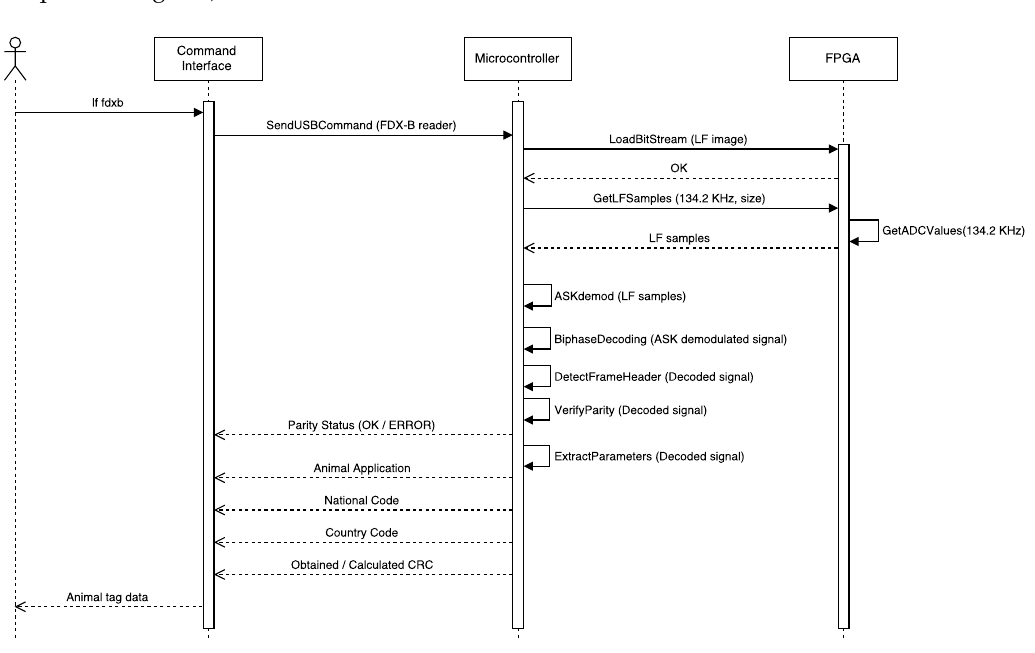
Figure 25. Sequence diagram of the Proxmark 3 FDX-B